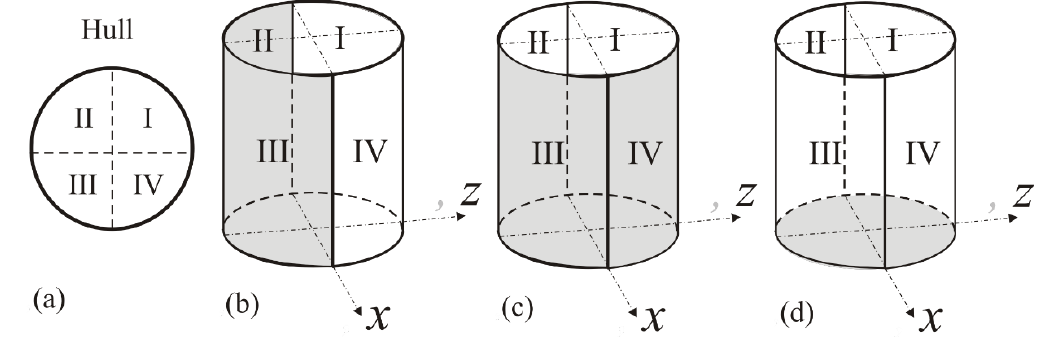
Figure 6. Scheme of application of the reaction forces applied in the hole of the bracket: ( a ) hole area division in quadrants for application of forces, ( b ) areas where loads on z -axis are applied, ( c ) areas where loads on the x -axis are applied, ( d ) areas where loads on the y -axis are applied.